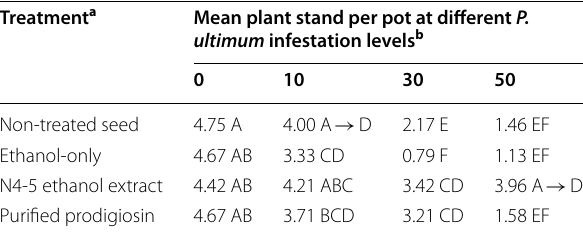
Table 2 Suppression of damping-off of cucumber caused by Pythium ultimum in soil-less mix with prodigiosin purified from ethanol extract of Serratia marcescens N4-5 Treatment a